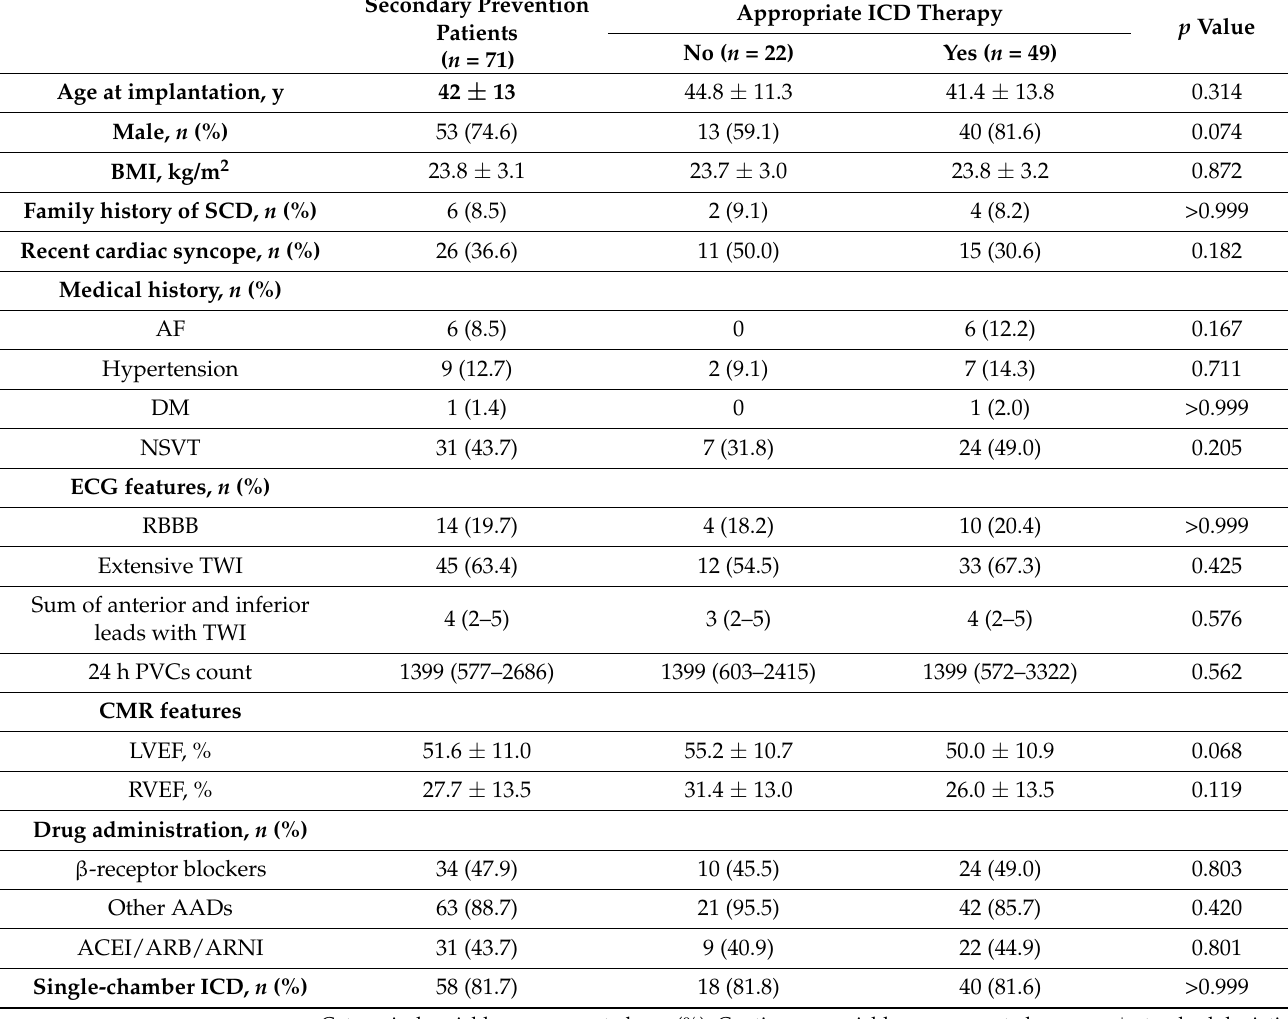
Figure 3B) in the sustained VT/VF group (i.e., the secondary prevention population). Table 2. Comparisons between secondary prevention patients with and without ICD